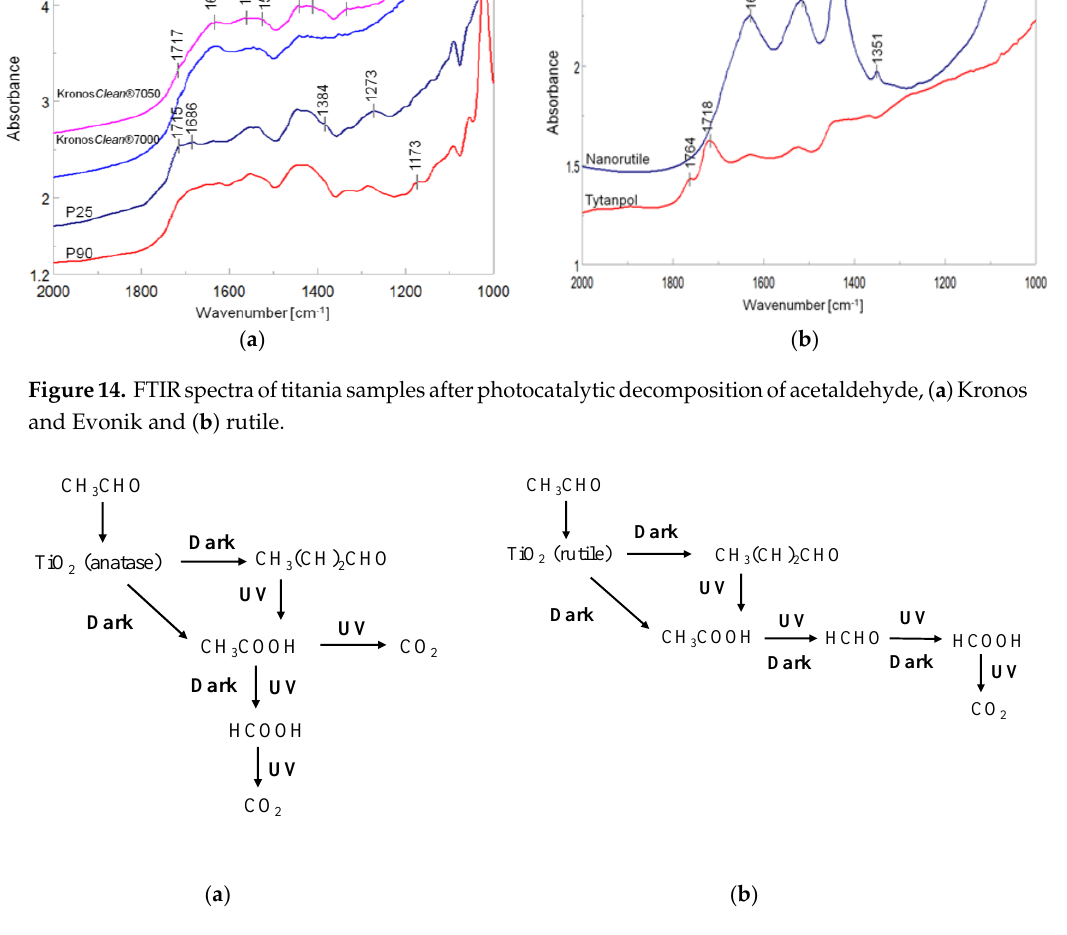
Figure 15. Scheme of the acetaldehyde conversion on titania surface during adsorption in the dark and photocatalytic decomposition under weak UV irradiation: ( a ) anatase, ( b ) rutile.